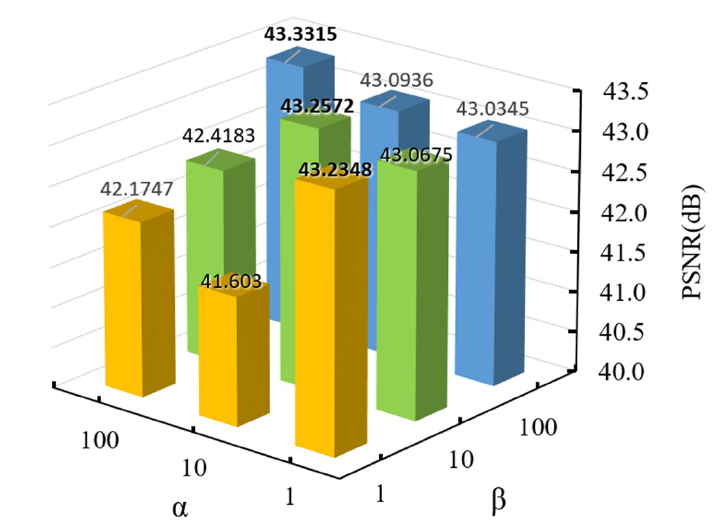
Figure 11. The variation of PSNR with α and β with the Pavia University